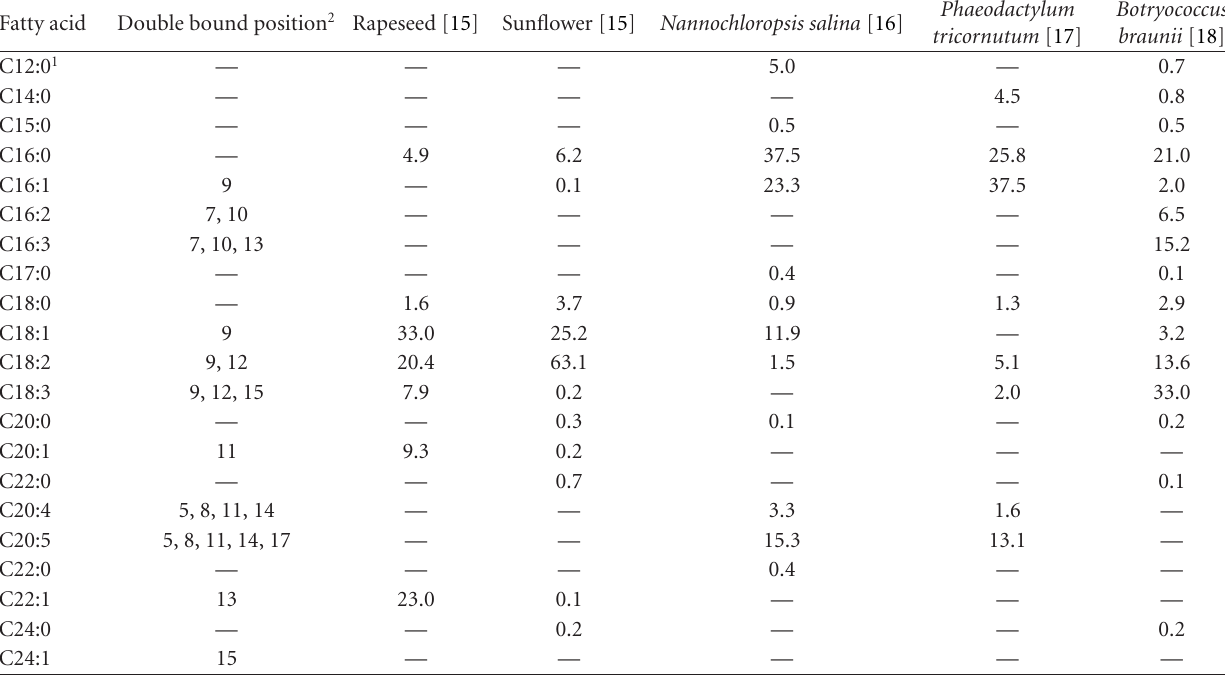
— — — — 1 Fatty acid with chain length of 12 carbon atoms and 0 double bonds. The same nomenclature applies for all other fatty acids. 2 Double bound position beginning from the carboxyl